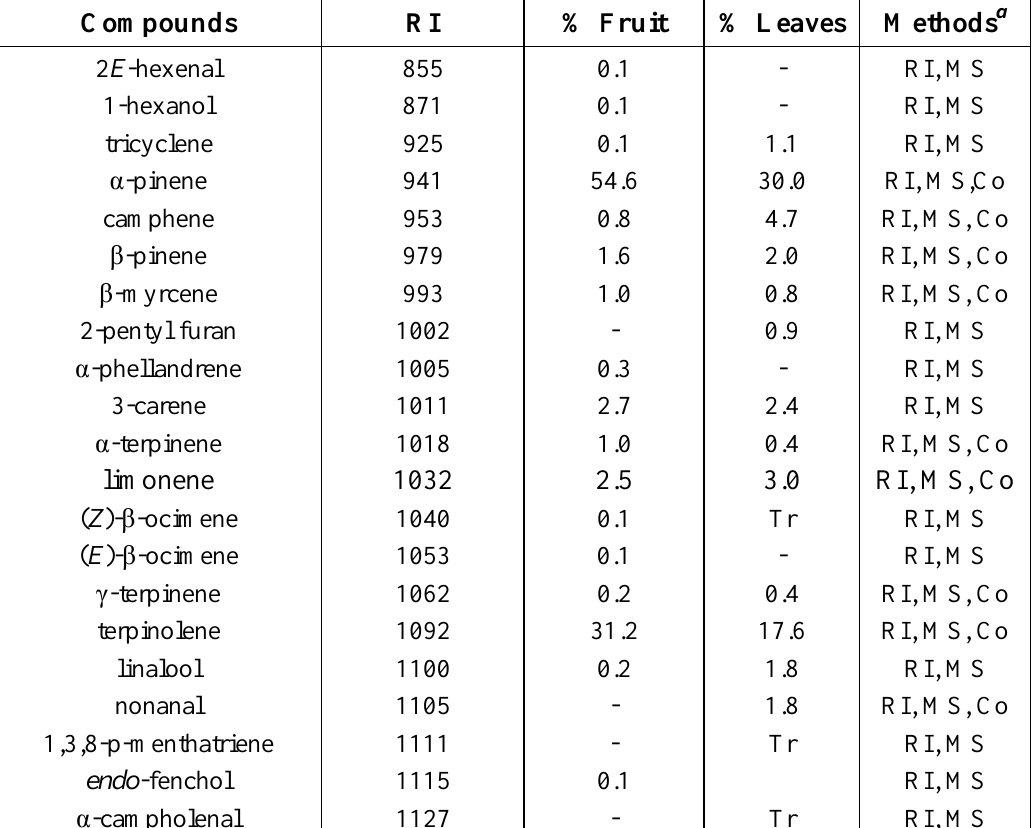
Table 1. Percentage composition of the essential oils of whole unripe fruits and leaves of Pistacia